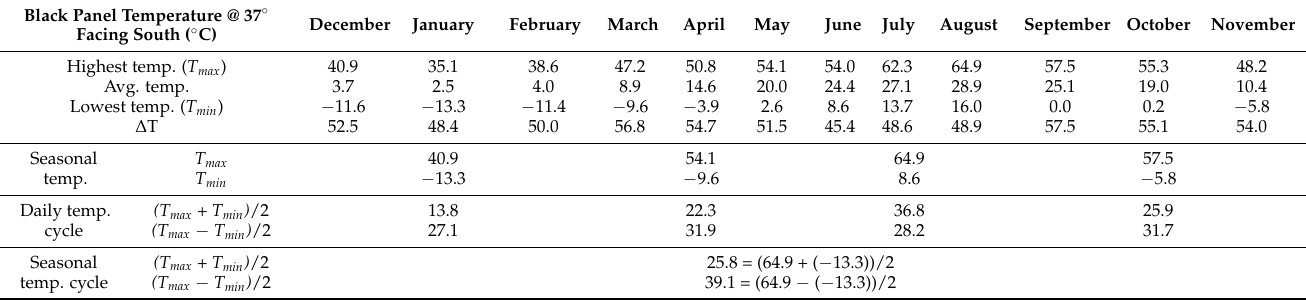
Table 2. Four-year monthly average black panel temperatures at solar angle of 37 ◦ , facing